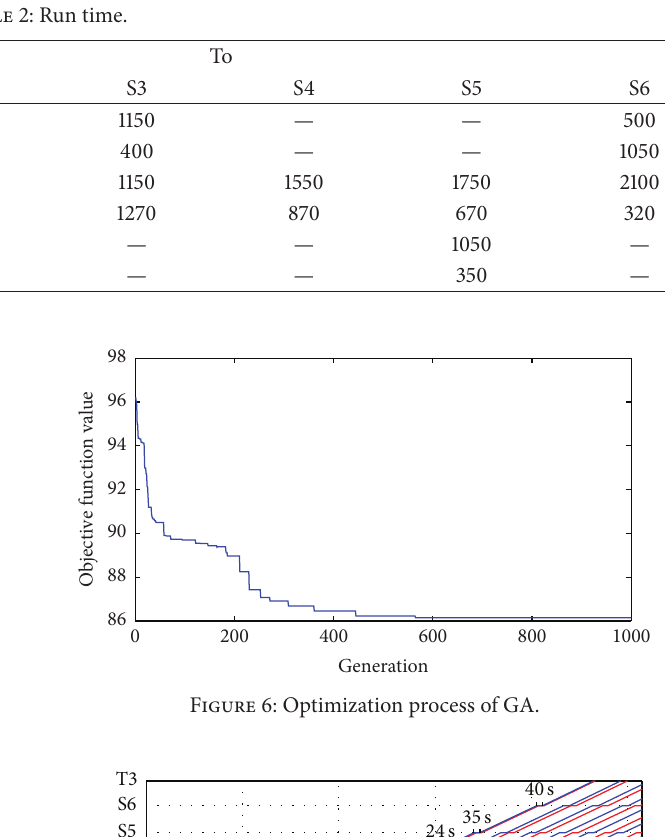
Table 2: Run time.